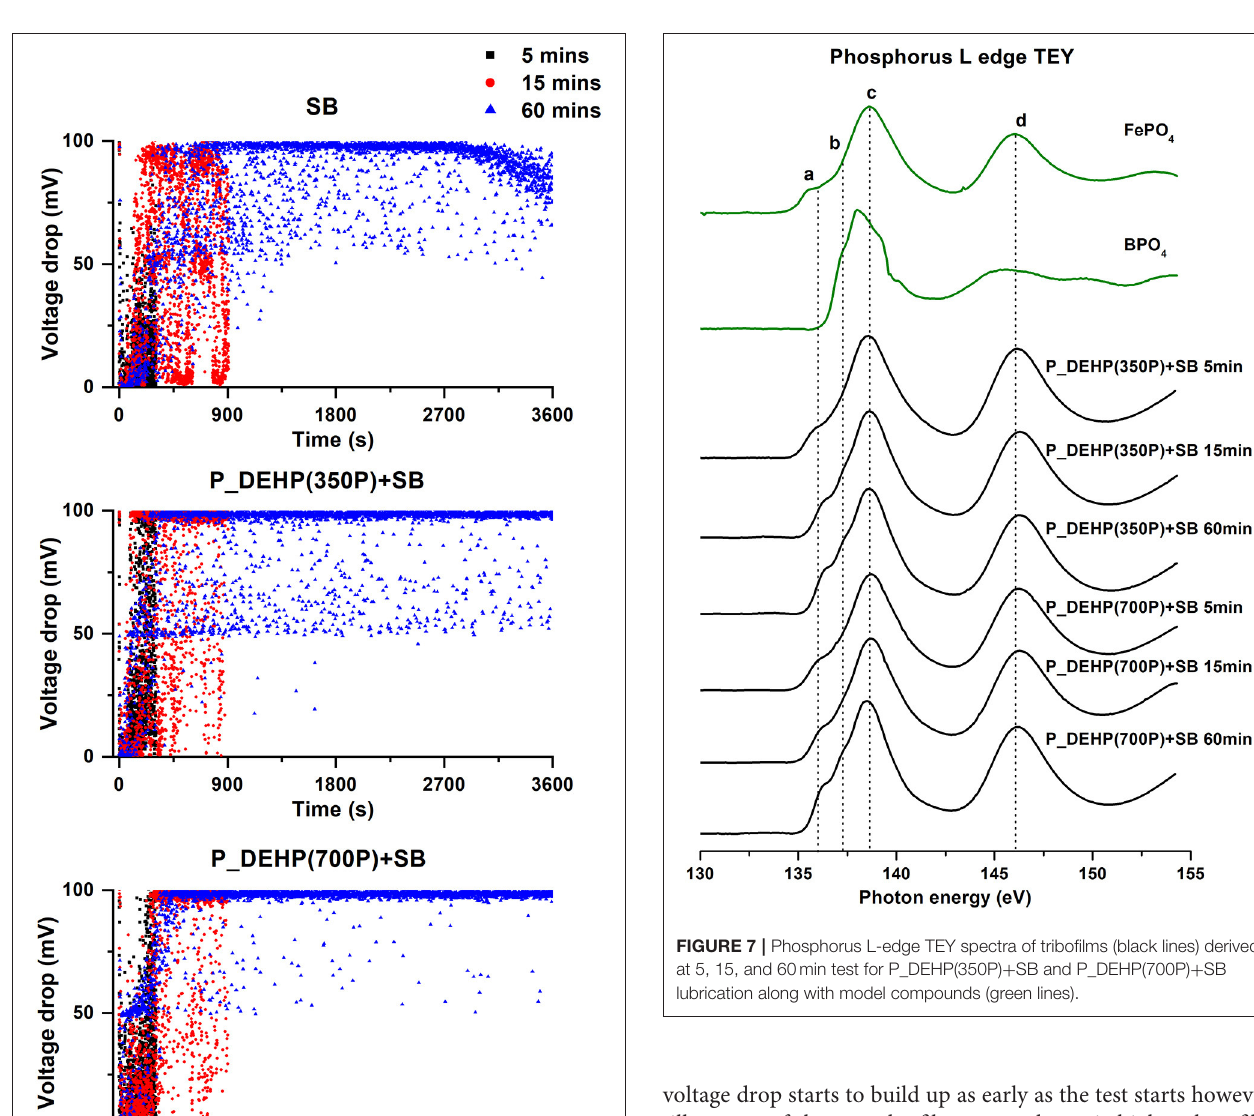
for the test run under P_DEHP(350P) + SB lubrication shows a relatively small incubation time for tribofilm formation. Voltage drop starts to form as early as ∼ 100 s from the beginning of the 5, 15, and 60 min tests. After ∼ 100 s, voltage drop values vary between 50 and 100 mV. These results indicate that the addition of phosphorus from P_DEHP at 350P ppm to SB promotes tribofilm formation in a very short time and once the films are formed film formation rate is higher than film removal under shearing, thus the voltage drop does not go back to 0 mV and stays between 50 and 100 mV. In the case of P_DEHP(700P) + SB,